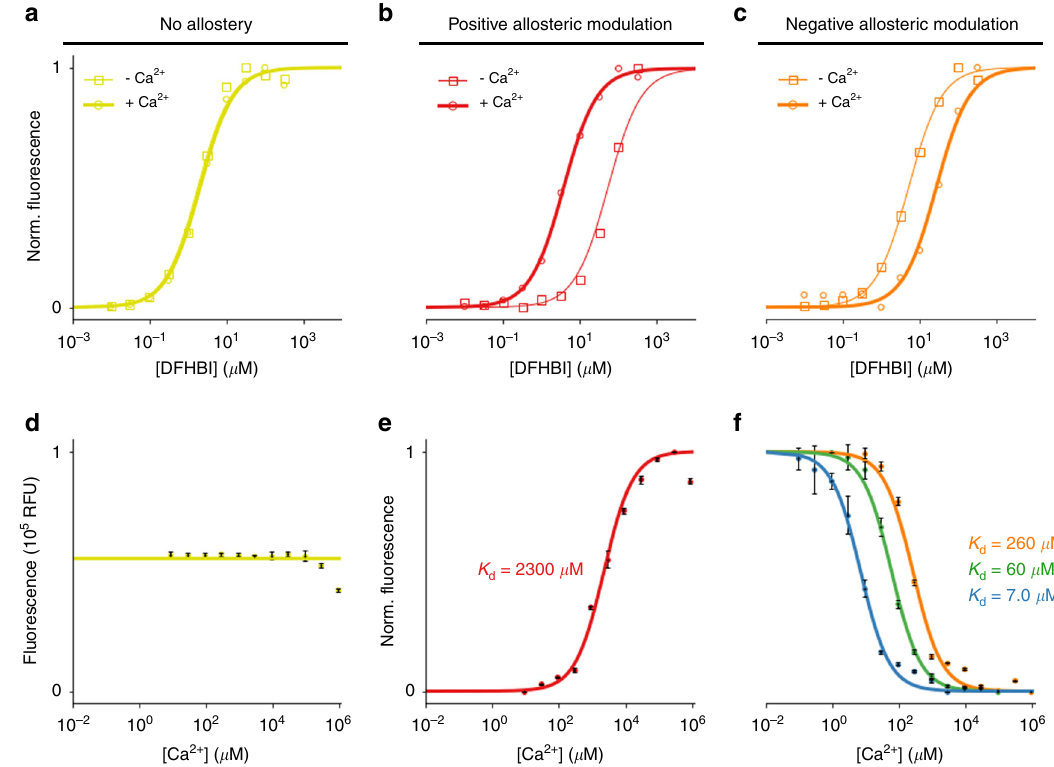
Fig. 4 In vitro characterization of Ca 2 + -responsive mFAPs. a – c DFHBI titration in the absence of Ca 2 + (squares) and presence of Ca 2 + (circles) . a For mFAP2b, Ca 2 + does not affect DFHBI binding. b For EF1p2_mFAP2b, binding of Ca 2 + and DFHBI exhibit positive allostery. c For EF1n_mFAP2b, binding of Ca 2 + and DFHBI exhibit negative allostery. a – c Normalized fl uorescence intensities ( n = 1) are fi t to a sigmoid function using non-linear least squares fi tting (lines) . d – f Ca 2 + titrations with excess DFHBI concentration compared to protein concentration. d Unnormalized mean fl uorescence intensities of mFAP2b demonstrating a lack of Ca 2 + -responsiveness. e Normalized mean fl uorescence intensities of EF1p2_mFAP2b (with one EF-hand motif, K d = 2300 µ M) demonstrating positive allostery between DFHBI and Ca 2 + binding. f Ca 2 + -responsiveness is dependent on the number of EF-hand motifs inserted into loop7, as exempli fi ed by the normalized mean fl uorescence intensities of EF1n_mFAP2b (with one EF-hand motif, K d = 260 µ M), EF2n_mFAP2b (with two EF-hand motifs, K d = 60 µ M), and EF4n_mFAP2b (with four EF-hand motifs, K d = 7.0 µ M), demonstrating negative allostery between DFHBI and Ca 2 + binding. d – f Error bars represent the s.d. of the mean of three technical replicates. The means ( n = 3) are fi t to a d constant function, or e sigmoid or f inverse sigmoid function with Hill coef fi cients of 1, using non-linear least squares fi tting (lines) to obtain K d values (Supplementary Table